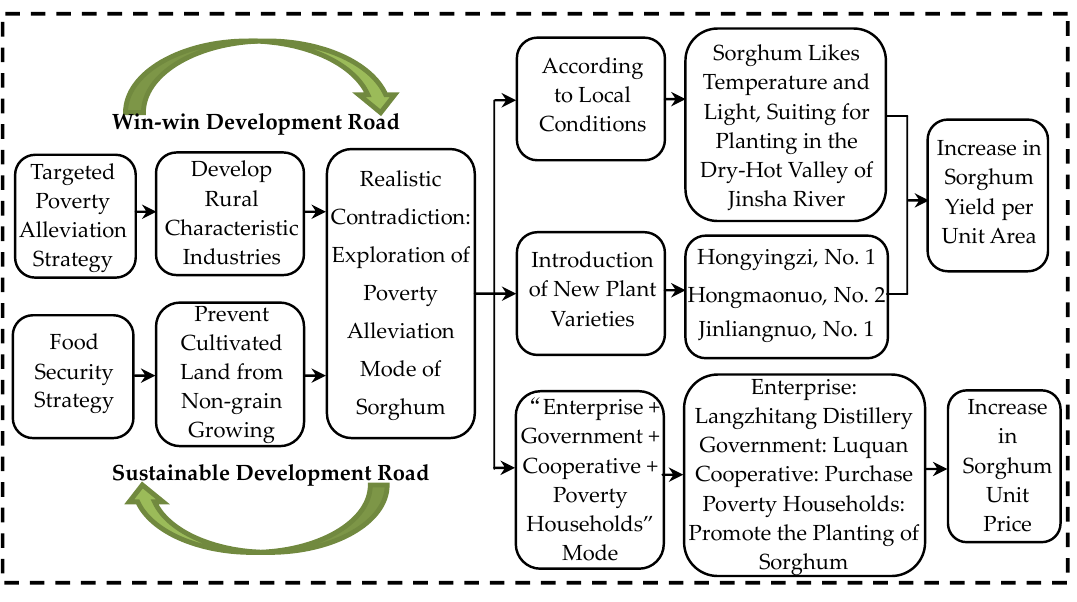
Figure 5. Sustainable mode of sorghum planting industry leading poverty alleviation in the dry-hot valley area of Jinsha River in Luquan County.